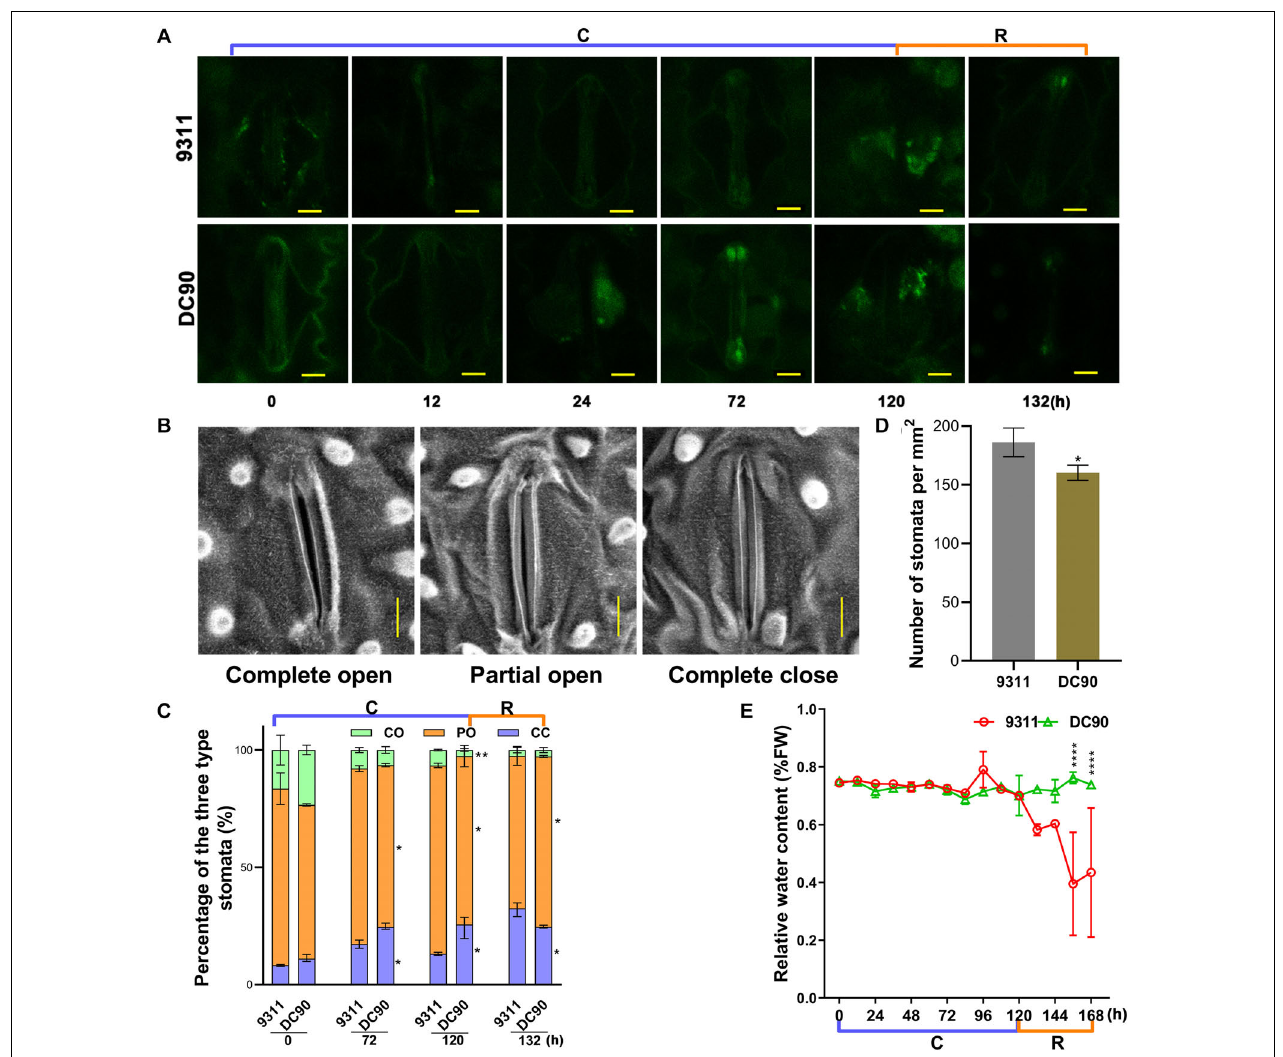
FIGURE 8 | The accumulation of H 2 O 2 in stomatal guard cells and stomatal movements of leaves in response to chilling stress and recovery treatment. (A) H 2 O 2 accumulation in leaf guard cells of 9311 and DC90 at chilling and recovery treatment timepoints. (B) Leaf stomatal opening during chilling and recovery treatment. (C) The percentages of three levels of stomatal opening in 9311 and DC90 ( n = 228 stomata for 9311; n = 208 stomata for DC90). (D) Stomatal density of the middle part of leaves of 9311 and DC90 ( n = 8). Four random fields were used in each repeat. (E) Relative water content of 9311 and DC90 ( n = 3). Scale bar, 5 µ m in (A,B) ; data are presented as the mean ± SD in (C–E) . * Significant at P ≤ 0.05 and **, ***, **** significant at P ≤ 0.01 according to Student’s t